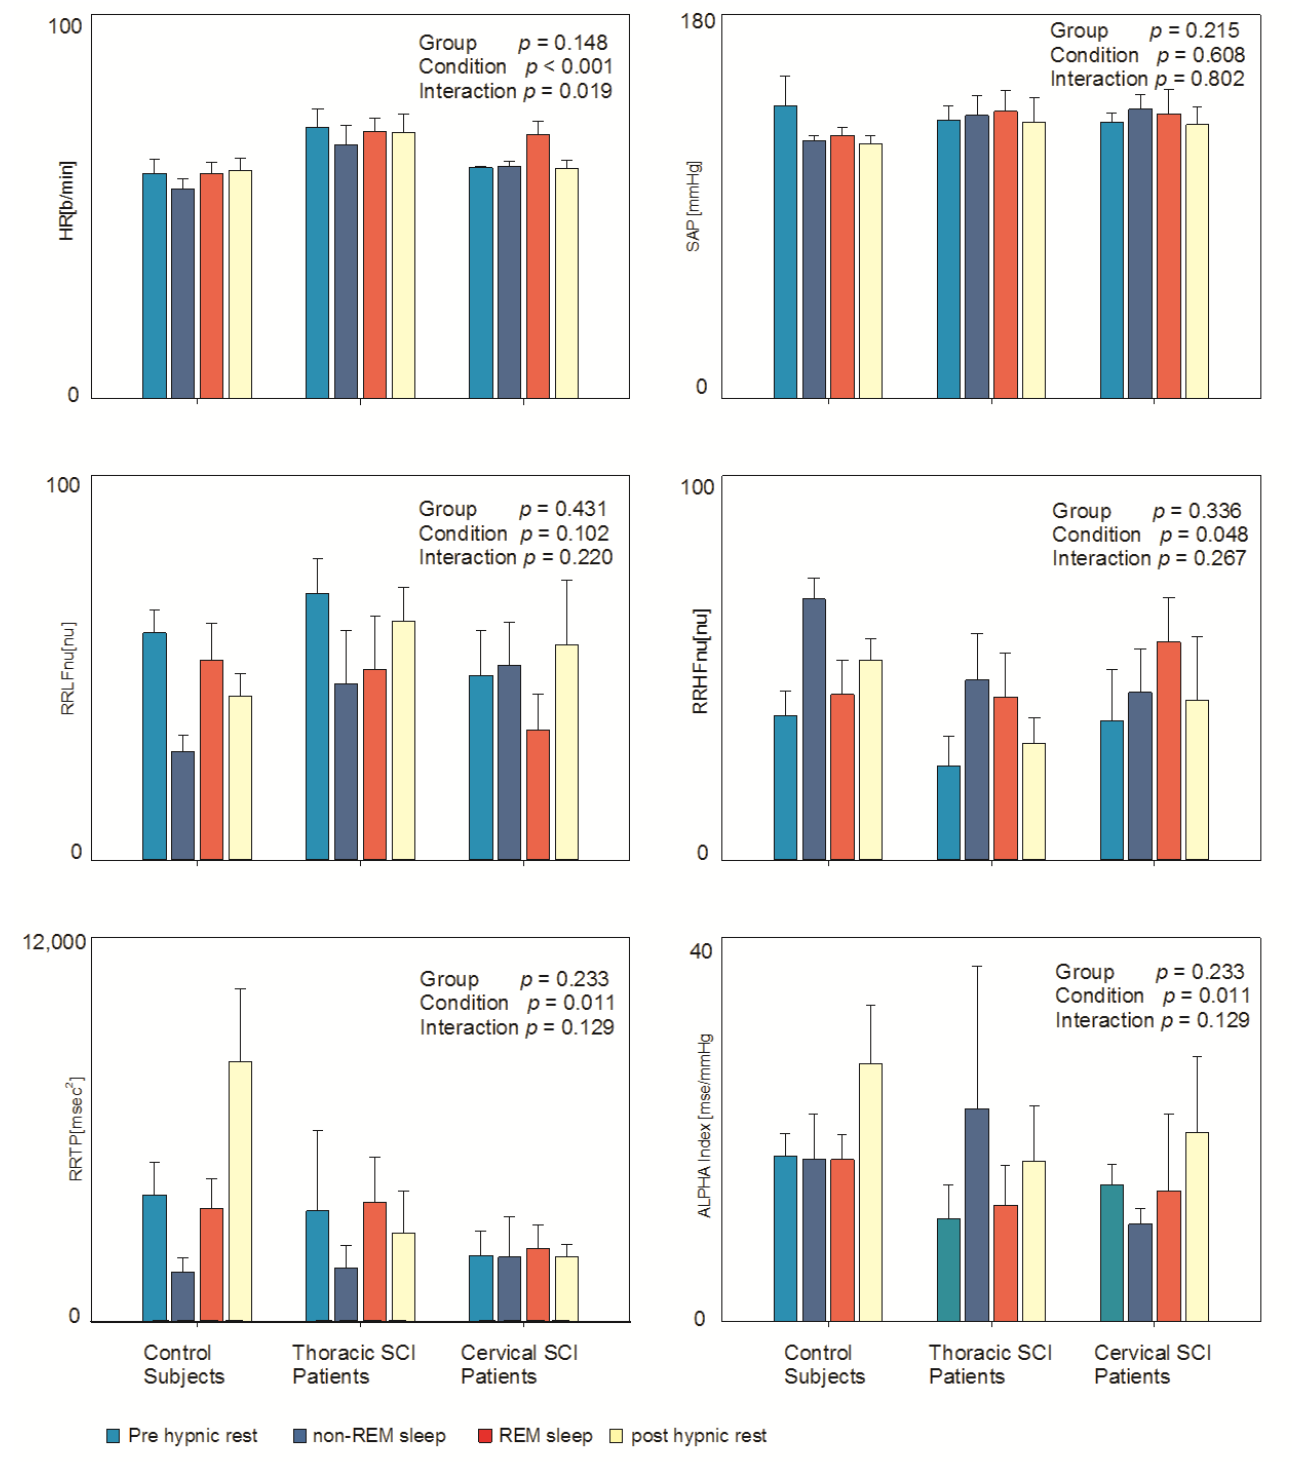
Figure 1. Hemodynamic and autonomic indices in the three examined groups (controls; thoracic and cervical Spinal Cord Injury) in different (spontaneous) conditions: pre-hypnic rest, NREM sleep, REM sleep and post-hypnic rest. Results of mixed model analysis are indicated in individual panels.